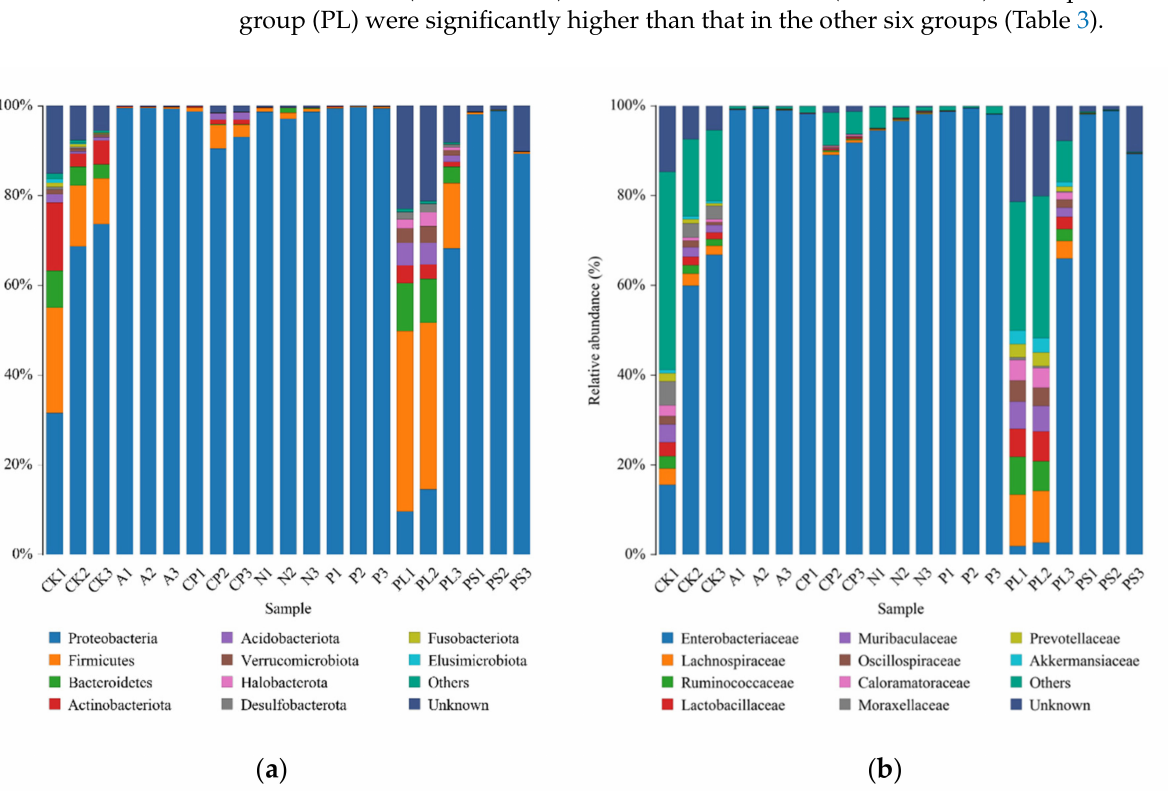
Figure 3. Bacterial composition of the top 10 relative abundances at ( a ) the phylum level and ( b ) the family level. Each color represents a species, and the height of the color block indicates the proportion of the species in relative abundance. Other species are incorporated as “Others” shown in the diagram. “Unknown” represents species that have not received a taxonomic